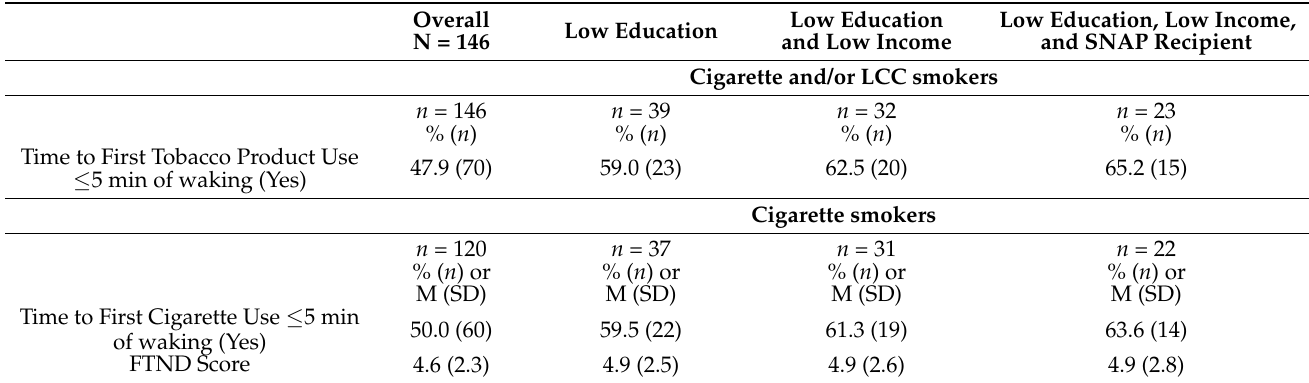
Table 4. Depth of Socioeconomic Deprivation by Time to First Tobacco Product Use, Time to First Cigarette Use, and FTND